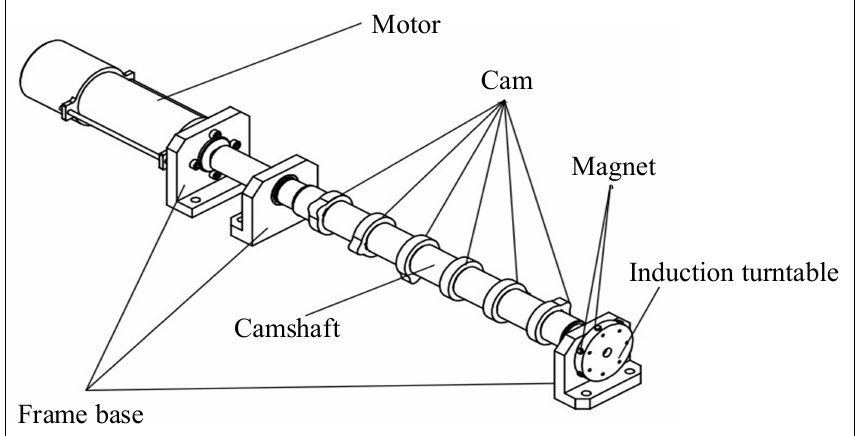
Figure 4. Driving schematic diagram of the net opening and closing mechanism.